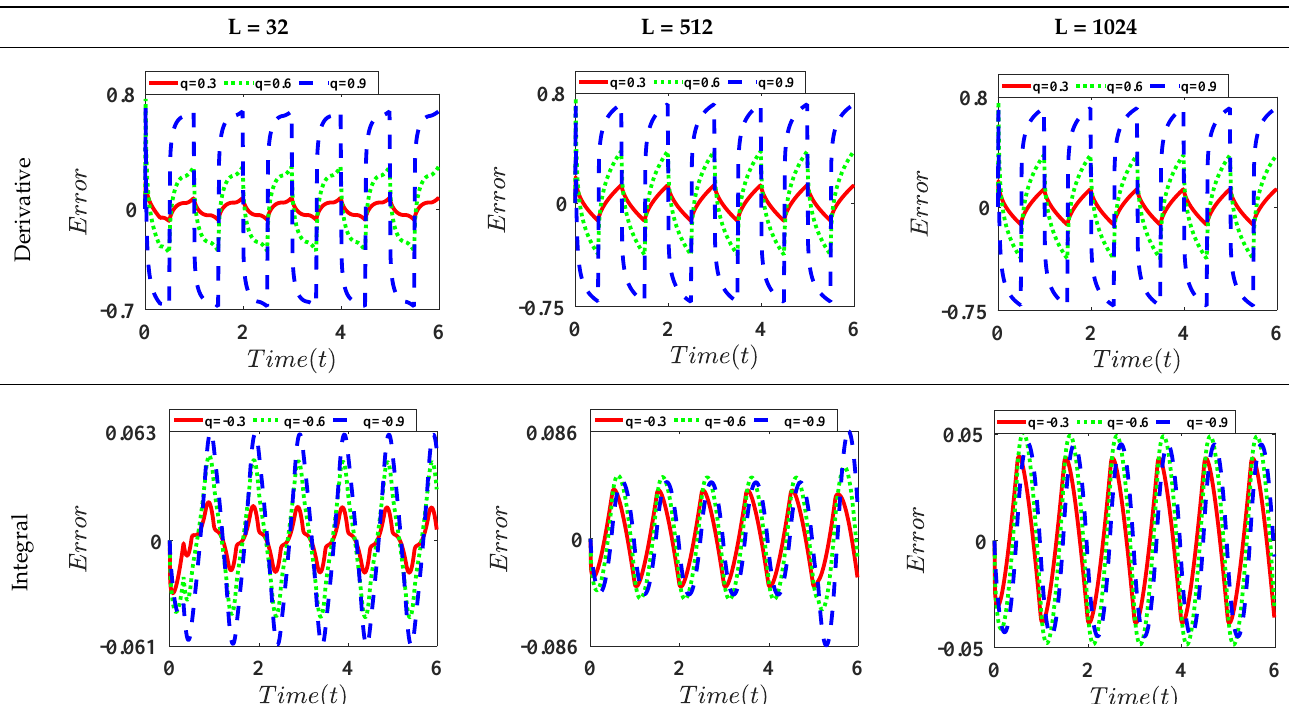
Table 4. The error of the proposed design results (differentiator and integrator) for a triangle signal input with respect to MATLAB